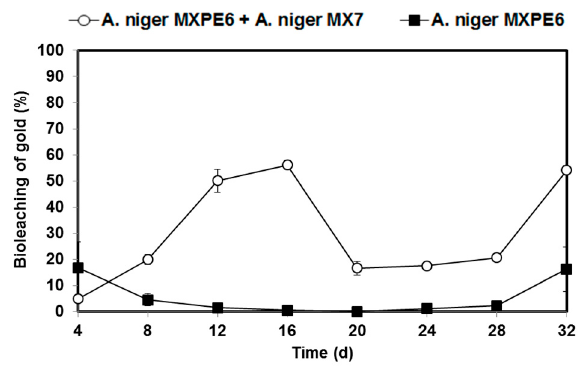
Figure 5. Leaching of gold at room temperature (19–23 °C) for 32 days. Data are given as means ± = standard error; n = 3. standard error; n